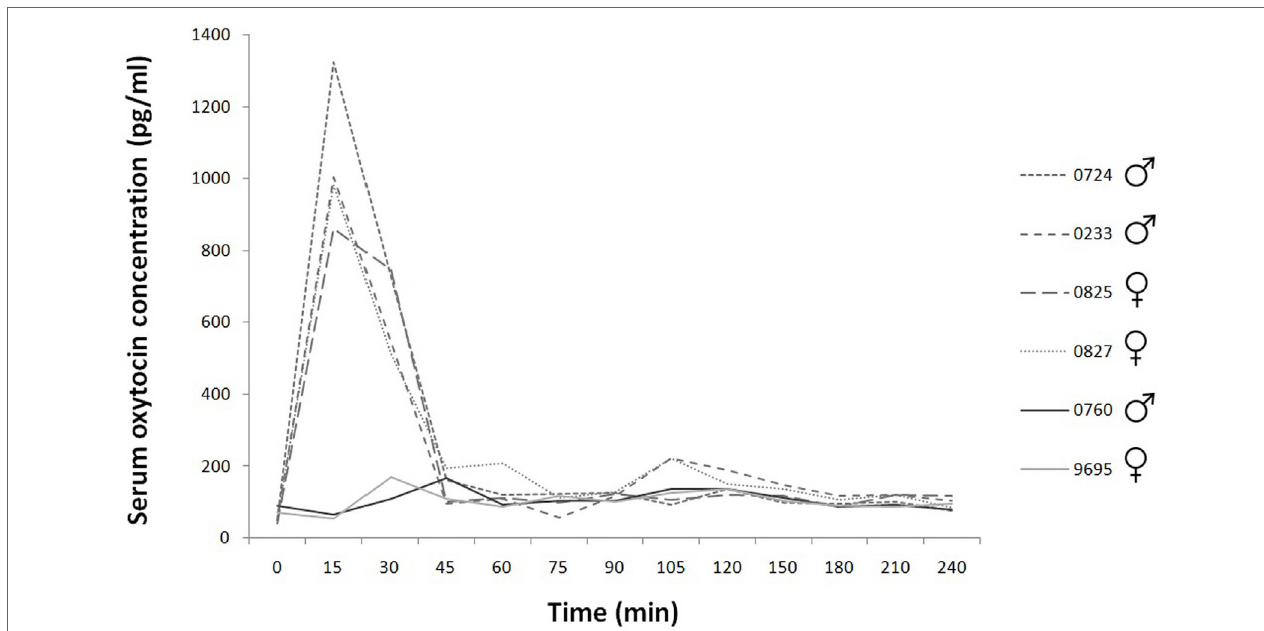
FigUre 1 | Time course of individual serum oxytocin concentrations during the 240 min. Experimental group: dashed line; control group: continuous line.